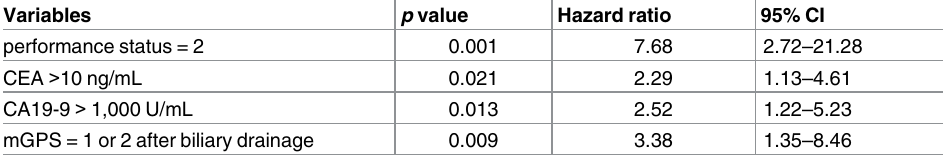
Table 3. Multivariate analysis in relation to overall